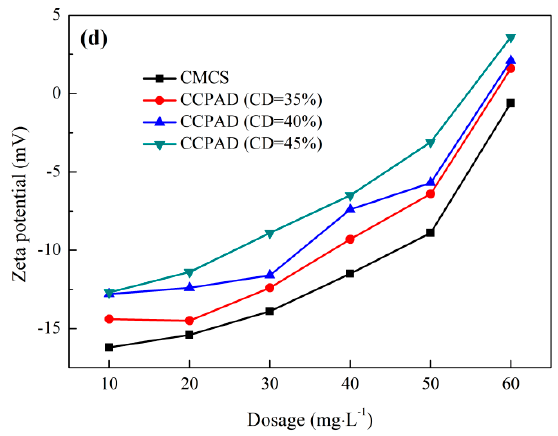
Figure 6. Effect of cationic degree on sludge dewaterability: ( a ) supernatant turbidity, ( b ) moisture content of filter cake, ( c ) SRF, and ( d ) zeta potential.